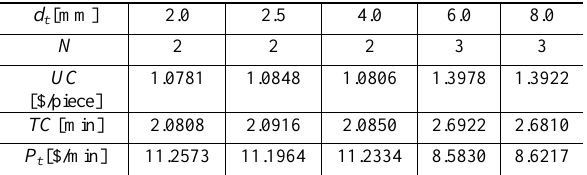
Table 3. Optimal solutions after 20 computations.